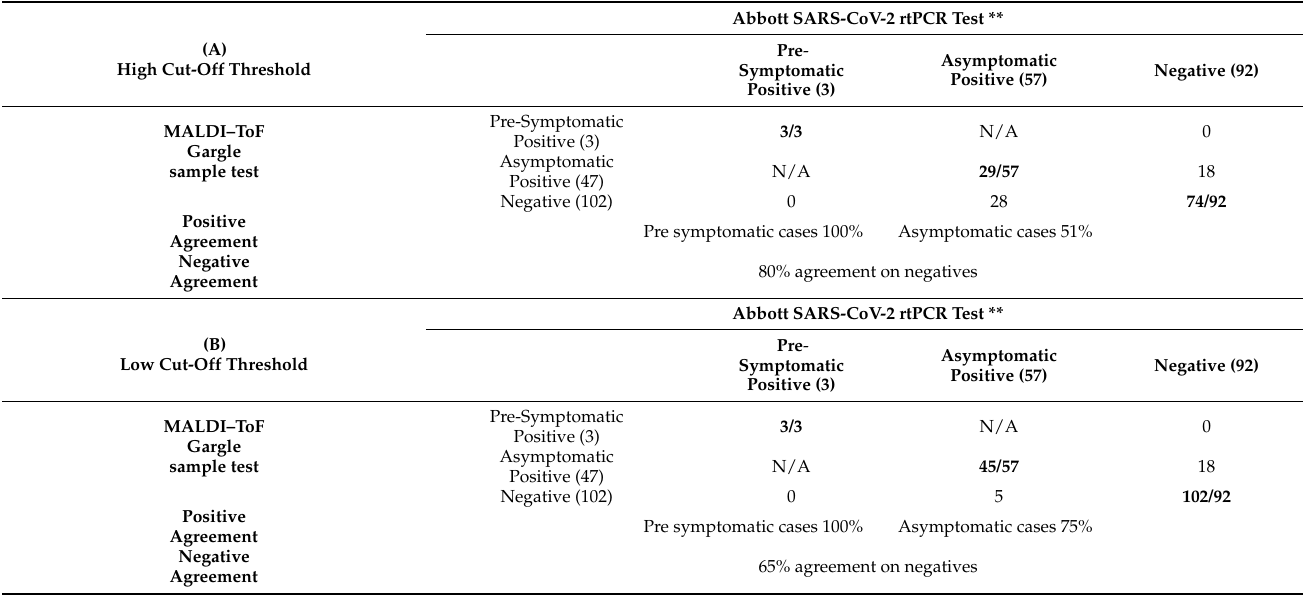
Table 3. Tabulated results of a comparison of the MALDI–ToF MS test for SARS-CoV-2 and an EUA rtPCR test with a low threshold ( A ) and high threshold ( B ) of scoring positive the detection of elevated S1, S2 and S2 (cid:48) viral proteins and IgA heavy chain in the saliva gargle